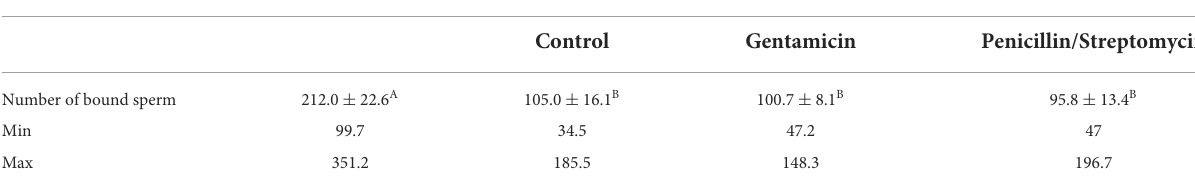
TABLE 3 Mean ( ± SE) values and range (Min—Max) for number of sperm bound to the perivitelline membrane of hen egg yolk in fresh and frozen-thawed semen from collared peccaries ( n = 10) supplemented or not with different antibiotics (gentamicin and streptomycin-penicillin